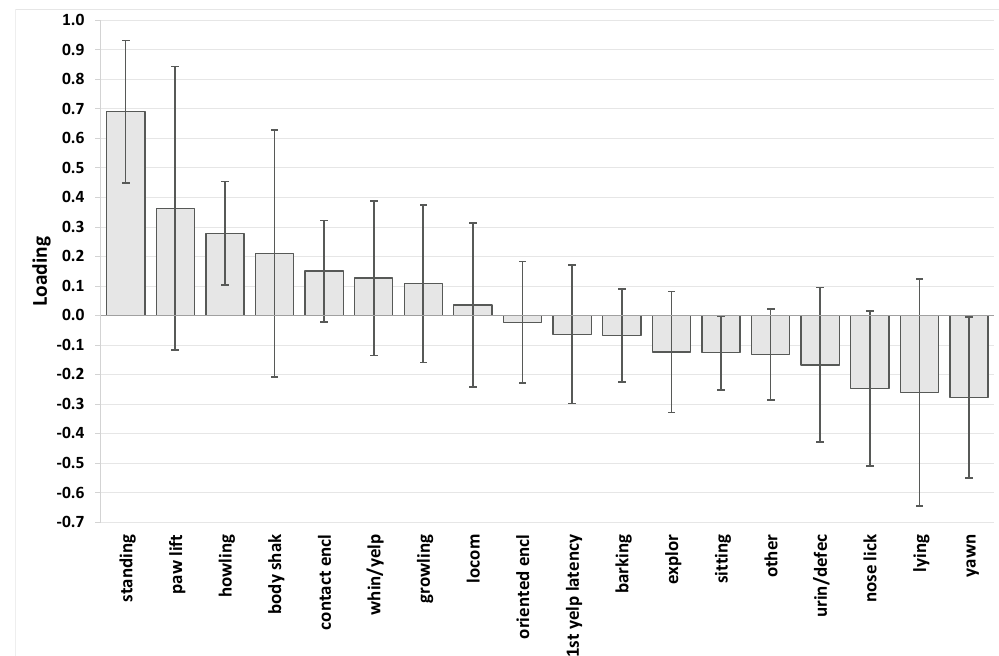
Figure 2. Loadings bar chart of OPLS of isolation test variables versus maternal care PCA score. Positive loadings (upward pointing bars) indicate the puppy behaviours that are positively associated with maternal care score, and negative loadings (downward pointing bars) indicate the puppy behaviours that are negatively associated with maternal care score. Height of bars is an index of the strength of that association. However, the chart should be viewed and interpreted as a pattern. Whiskers indicate 95% confidence interval. Legend: standing (Standing), paw lift (Paw lifting), howling (Howling), body shak (Body shaking), contact encl (In contact with the enclosure), whin/yelp (Whining/Yelping), growling (Growling), locom (Locomotion), orientated encl (Behaviours orientated to the enclosure), 1st yelp latency (Latency to the first yelp/whine), barking (Barking), explor (Exploration), sitting (Sitting), other (Other behaviours), urin/defec (Urination and/or defecation), nose lick (Nose licking), lying (Lying), yawn (Yawn).